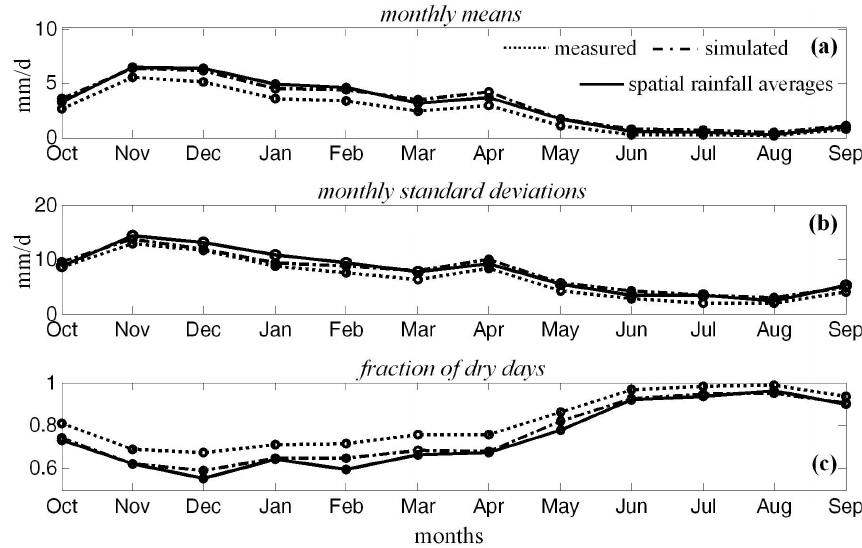
Fig. 14. Same as Fig. 13 but for the case when using point rainfall measurements from the location of the dam (point B in Fig.